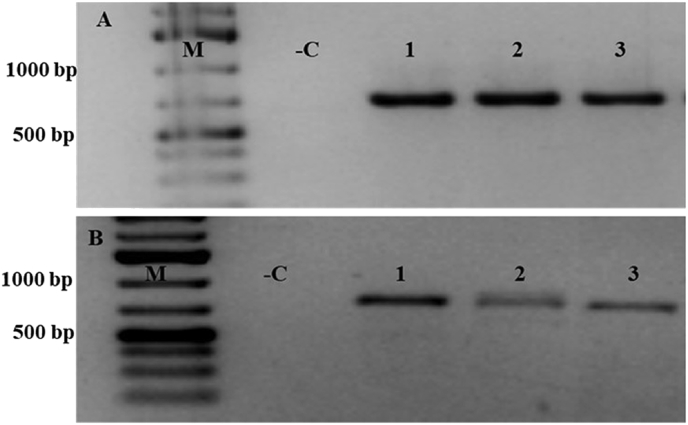
Gel electrophoresis for Pratylenchus coffeae obtained from banana roots collected from different agro-ecological zones of Tanzania. A and B represent P. coffeae amplified by primer pairs PC7ITSF/PC7ITSR (estimated size ∼676 bp) and PC11LSUF/PC11LSUR (estimated size ∼781 bp), respectively. Number 1: Representative nematode sample isolated from Zanzibar, 2: Southern Highlands Zone and 3: Northern Zone. -C represents a non-template negative control and M is a DNA marker (1 kb plus).